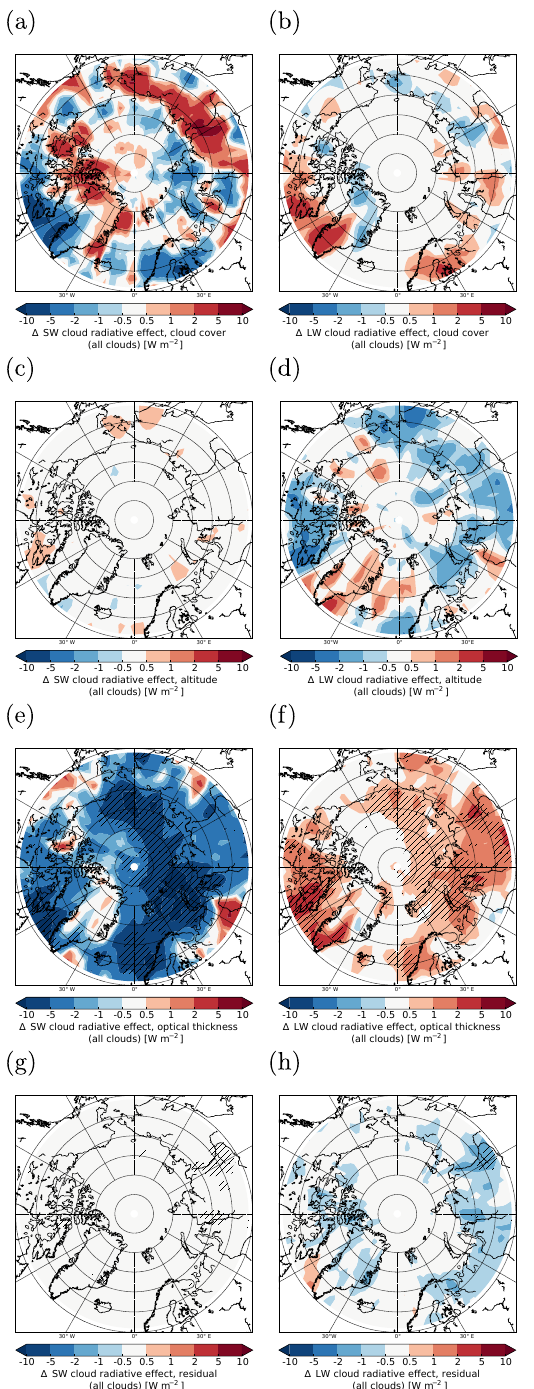
Figure 15. Different contributions to the changes in SW (left) and LW (right) CREs in late summer (July–August) caused by enhanced shipping: contribution from changes in (a, b) cloud cover, (c, d) cloud top altitude, and (e, f) cloud optical thickness. In (g) and (h) , the residual is shown. Hatched areas are significant at the 95% con- fidence